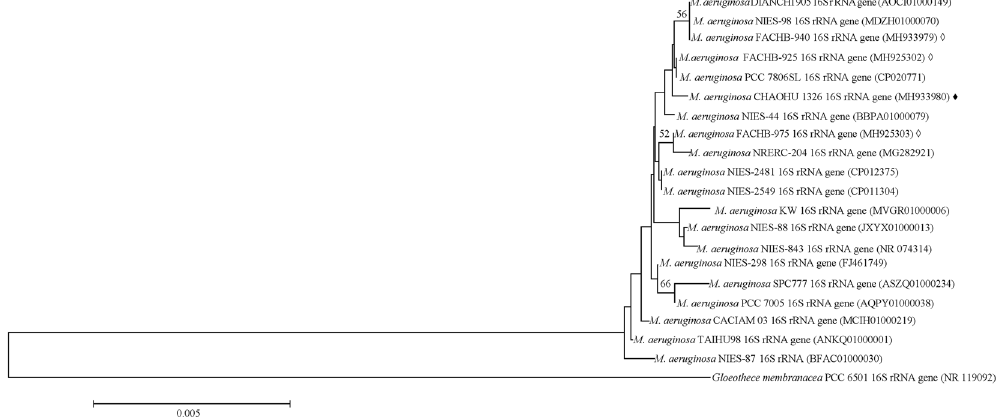
Figure 1. Neighbour-joining phylogenetic tree based on the 16S rRNA gene sequences of M. aeruginosa CHAOHU 1326 and other M. aeruginosa strains obtained from the GenBank database. Bootstrap values above 50% are shown at the branch nodes (1,000 replicates). Gloeothece membranacea PCC 6501 is used as outgroup. The scale bar represents 0.005 nucleotide substitutions per site. M. aeruginosa CHAOHU 1326 is indicated by the solid diamond ( ♦ ). Strains FACHB-925, FACHB-940, and FACHB-975 are marked by the empty diamond ( ◊